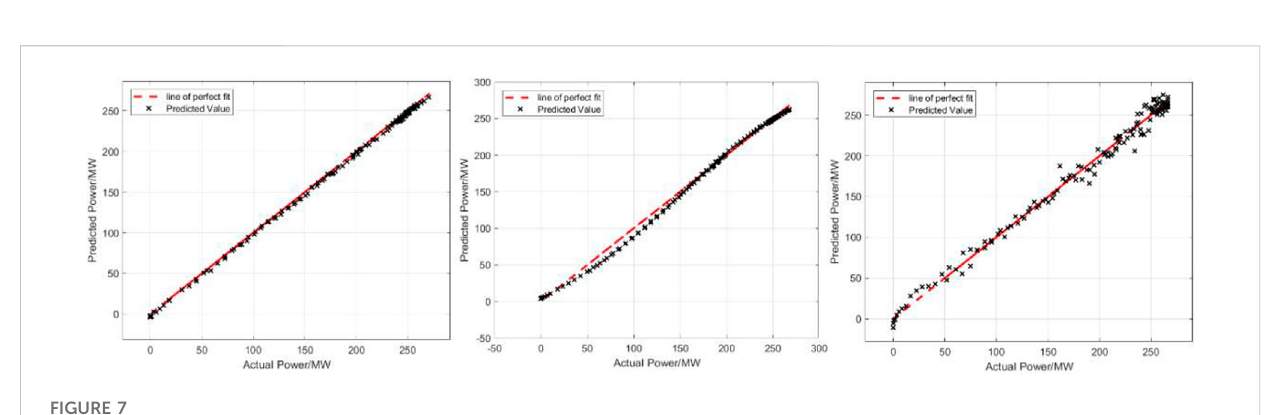
FIGURE 7 Comparison of the errors by three models.